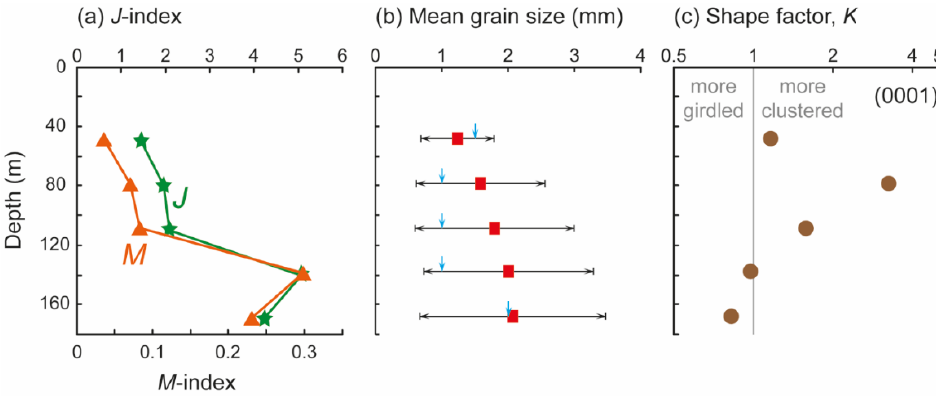
Figure 7. Plots of ( a ) J -index, ( b ) mean grain size, and ( c ) shape factor, K , as a factor of increasing depth. The range presented as black arrows and a blue arrow and in ( b ) denote the standard deviation and peak grain size, respectively. The shape factor is calculated from eigenvalues [53].